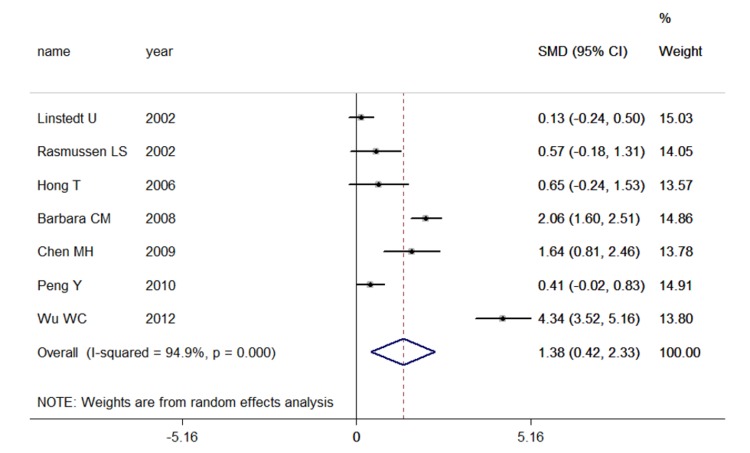
Studies of peripheral blood S-100β.Forest plot for S-100β displaying the results of the random effects meta-analysis for the association between peripheral blood S-100β and postoperative cognitive dysfunction (POCD). The standardized mean difference is presented on the horizontal axis; positive values denote higher serum levels in POCD patients; negative values denote higher serum levels in control subjects. The dashed line is at the overall standardized mean difference. CI, confidence interval; SMD, standardized mean difference.